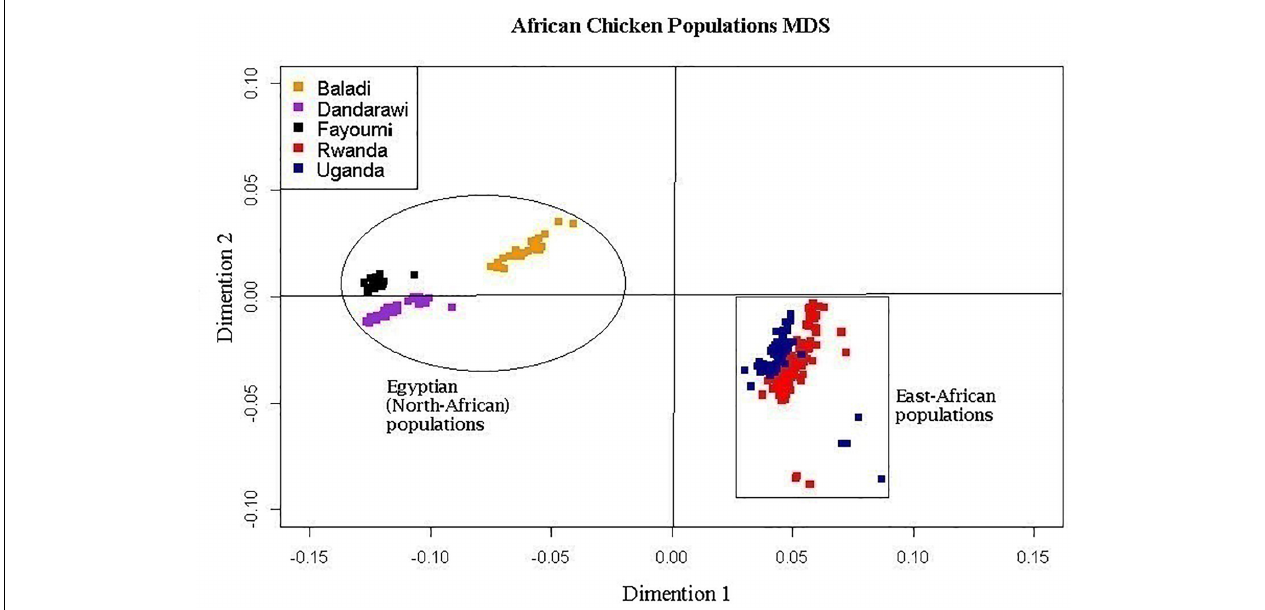
FIGURE 1 | Multi-dimensional scaling, MDS, plot showing the distinct sampled five native African (two East- and three North-African) chicken populations. Plot was constructed based on a matrix of genome-wide Identity-By-State scores calculated based on pairwise comparisons of the genetic distances for all individuals. African chicken populations are Baladi ecotype ( N = 31), Dandarawi breed ( N = 33), Fayoumi breed ( N = 30), Rwanda ecotype ( N = 100), and Uganda ecotype ( N = 72).